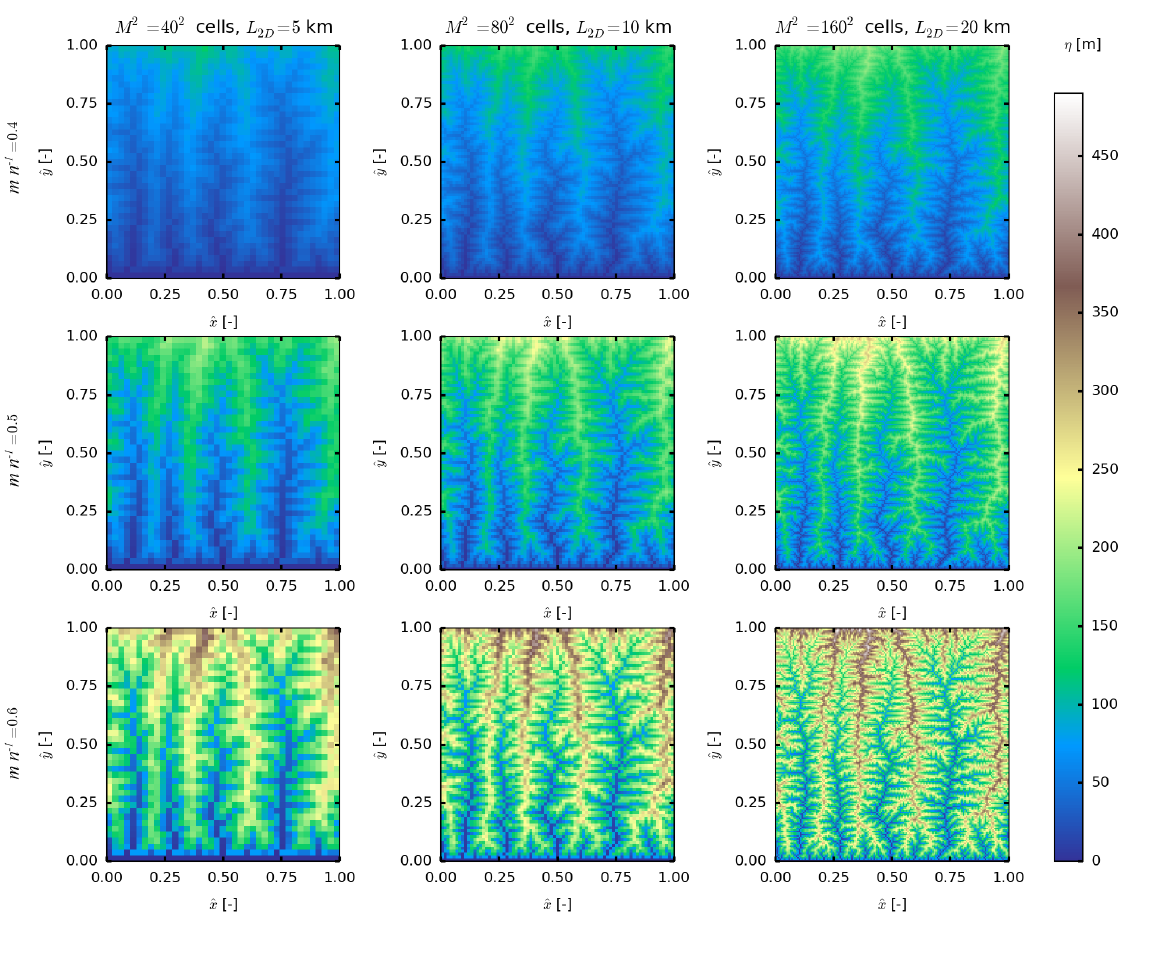
Figure 4. Nine 2-D numerical simulations at steady state for three different values of M 2 and three different values of m/n . In this figure, the grid size, L 2-D /M = 125m, is used in all the solutions. The value of K has been chosen to be different for each value of m/n for clarity in the figures. From left to right, the number of cells M 2 = 40 2 , 80 2 , and 160 2 . To make the relief of the landscapes comparable, the 2-D Pillsbury number, P 2-D , is set to 3.10 × 10 23 for solutions of all m/n ratios with L 2-D = 10km. To achieve this for υ = 1mmyr − 1 , increases with the number of cells because the ridge singularity is resolved at a finer